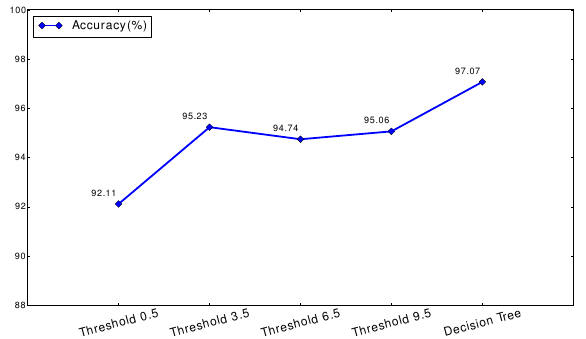
Figure 6. Detection Accuracy Comparison with Anomaly Detection